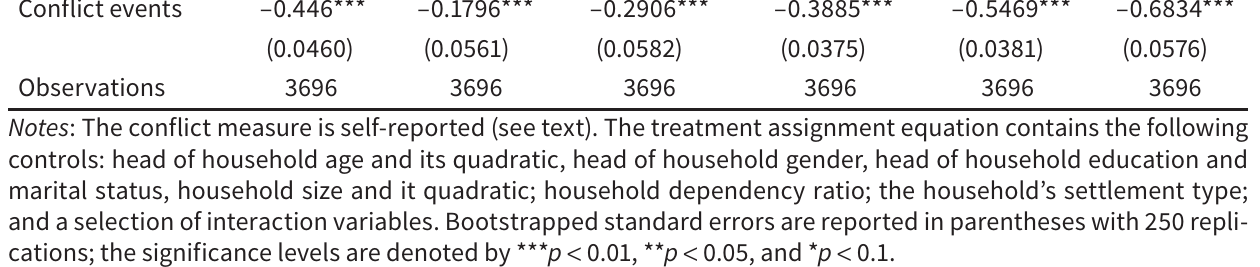
Table 4. Tables 11 and 12 report the econometric results using the self-reported conflict mea- sure for the Gini coefficient and the quantile treatment effects, respectively. The estimates for the Gini index are broadly comparable to those reported in Table 6 for 2003, while the quantile treatment effects confirm the sizeable contractions at the top end of the unconditional distri- bution for the same year.